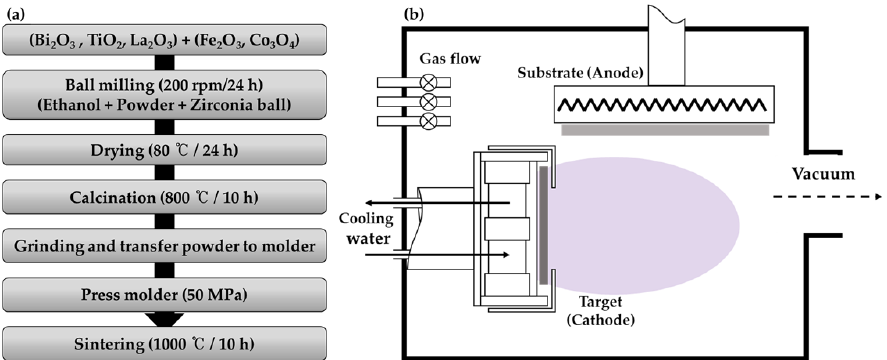
Figure 1. ( a ) the flowchart for the target fabrication procedure and ( b ) the schematic diagram of off-axis RF magnetron sputtering inter configuration.